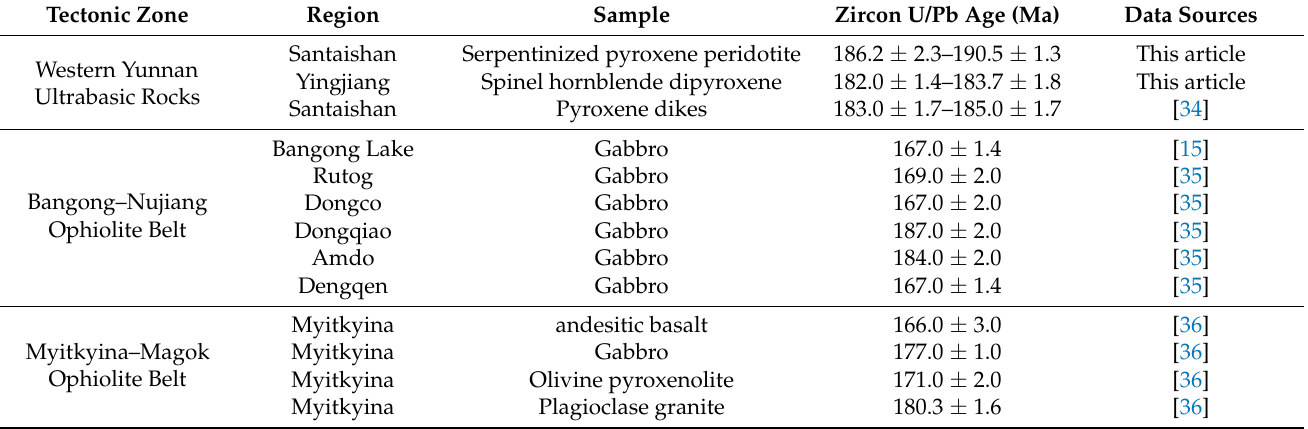
Table 1. Chronological data of ultramafic rocks in western Yunnan, Bangong–Nujiang, and Myitkyina–